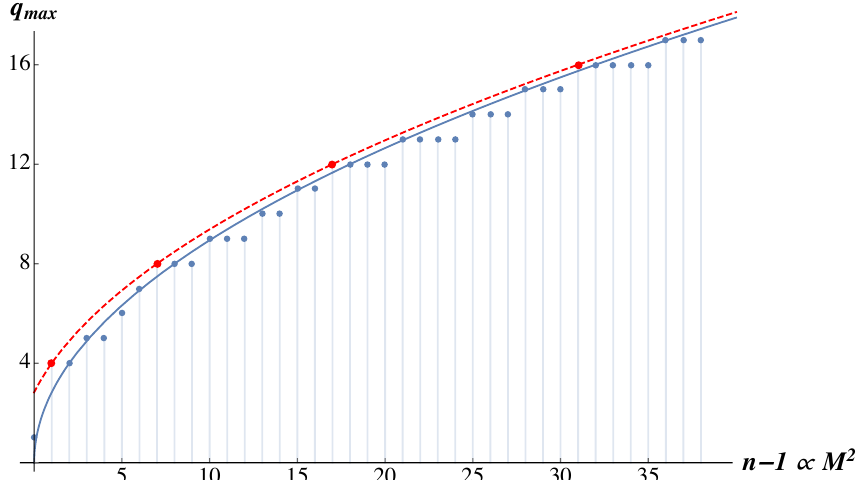
Figure 4 . Maximal charge q max ( n ) for a Bl 1 P 2 [4] (cid:12)bration over dP 2 , with (x ; y 1 ; y 2 ) = (6 ; 2 ; 2). 112 The general features of this strongly coupled theory are completely in line with the (cid:12)ndings of the previous examples, which correspond to weakly coupled